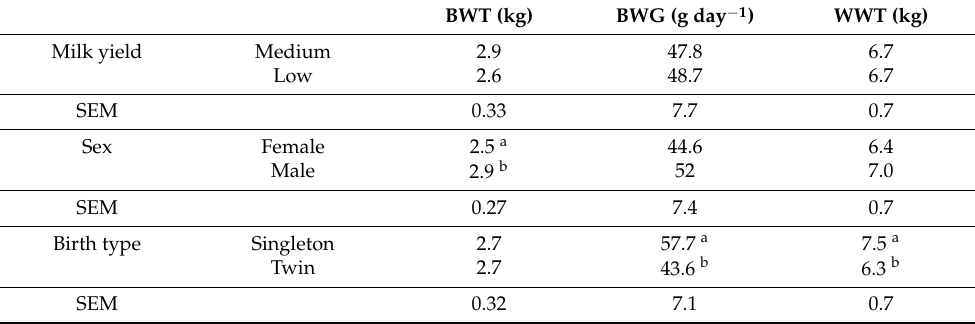
Table 4). Birth weight differed between kid’s sex, with males being heavier than females at birth ( p < 0.05; Table 4). Table 4. Birth weight (BWT), average daily bodyweight gain (BWG), and weaning weight (WWT) of kids from mixed-breed non-supplemented goats reared on a Xerophytic ecosystem in northern Mexico during the dry season (winter–spring) with different milk yield potentials (medium vs. low). BWT (kg) Milk